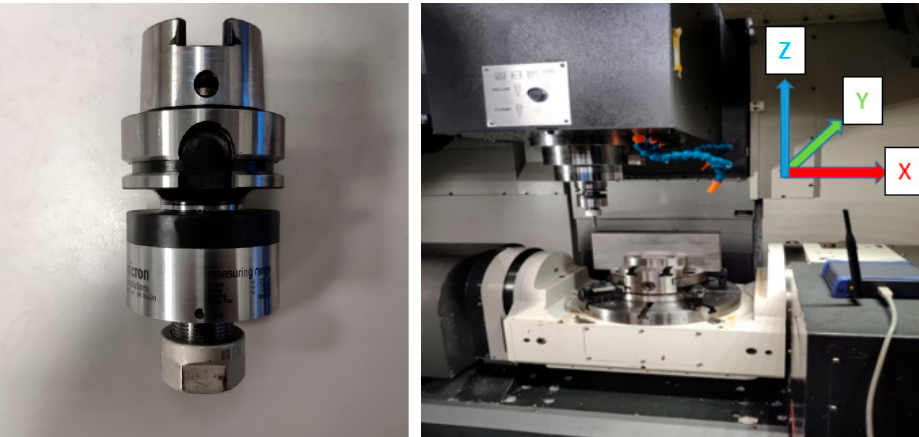
Figure 1. Sensory tool holder and machining center.